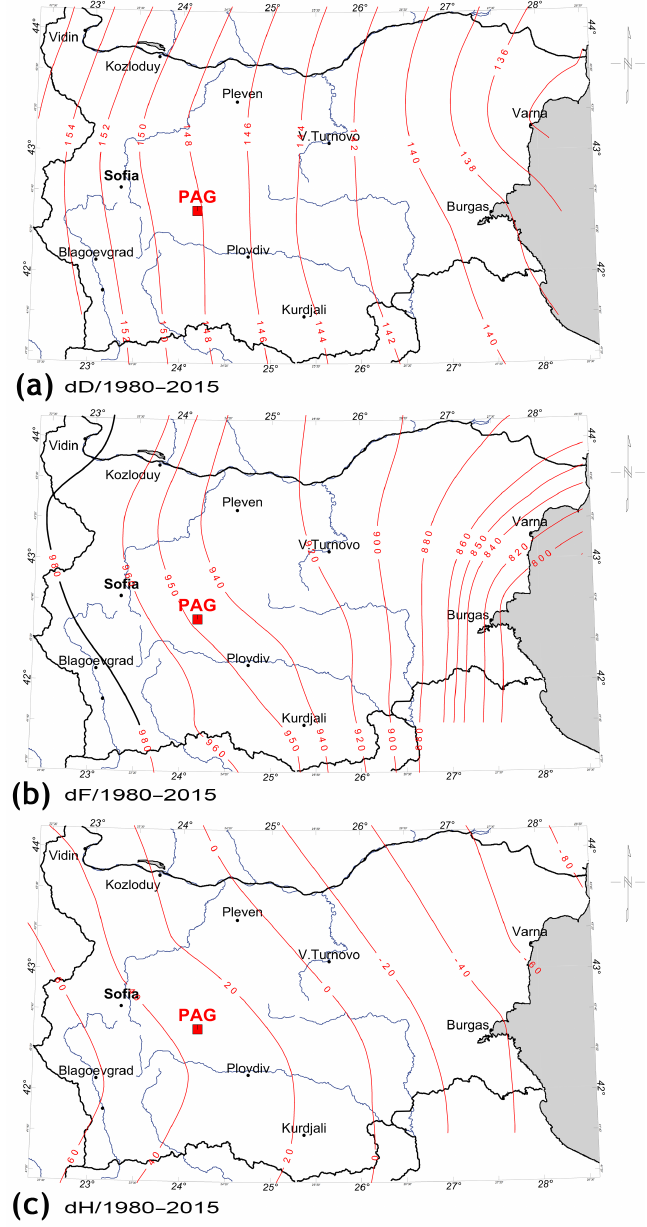
Figure 3. Isoporic maps of the accumulated change in the main field elements from 1980 to 2015 for (a) D (arcmin/35 years), (b) F (nT/35 years), and (c) H (nT/35 years), prepared from the Bulgar- ian repeat stations data reduced to 2015.0 epoch and annual mean values from neighbour observatories (SUR, GCK, IZN,